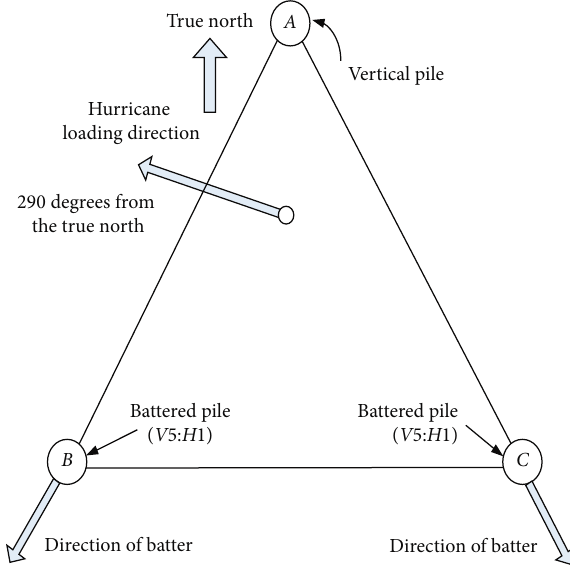
Figure 4: Pile foundation plan view of Platform X